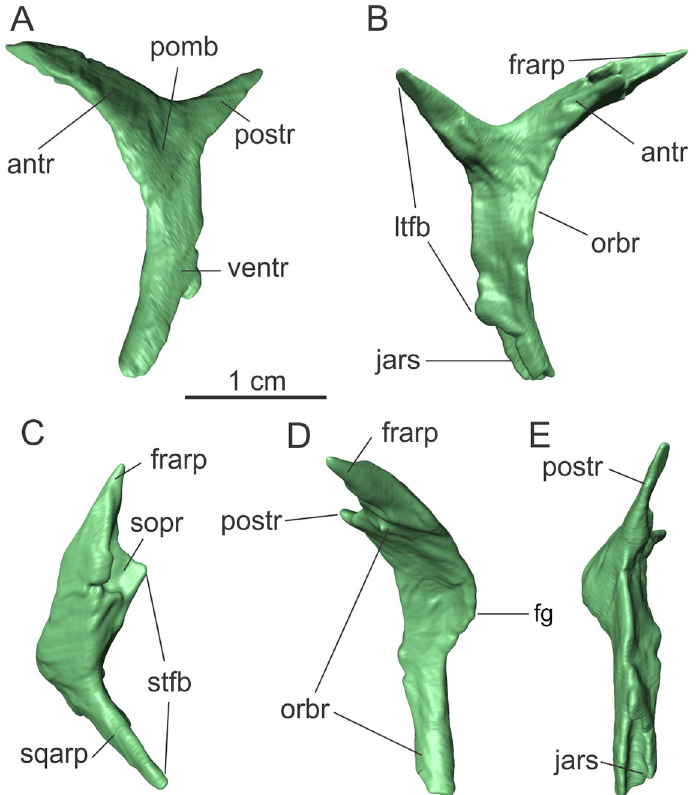
Fig 6. Left postorbital of the specimen MCP-3845-PV of Saturnalia tupiniquim in lateral (A), medial (B), dorsal (C), anterior (D) and posterior (E) views. Abbreviations : antr —anterior ramus; fg— flange; frarp— articulation process with the frontal; jars— articulation surface with the jugal; ltfb— border of the laterotemporal fenestra; orbr— orbital rim; postr— posterior ramus; sopr— socket for articulation with the parietal; sqarp— articulation process with the squamosal; stfb— border of the supratemporal fenestra; ventr— ventral ramus. On the medial surface of the lacrimal, a crest extends along the posterior margin of the shaft. It separates the groove associated with the lachrymal duct on the posterior surface of the bone from another dorsoventrally oriented, and anteroposteriorly concave, groove (‘gr’ in Fig 5D) on the medial surface of the bone, which extends dorsally for half the length of the poste- rior groove. The dorsal half of the lacrimal shaft is anteroposteriorly convex, following the con- cavity of the antorbital fossa on the lateral side of the bone. The medial surface of the anterior ramus also mostly follows the curvature on the opposite side of the bone, being dorsoventrally convex, except for its concave proximal third. This is due to the medial expansion (‘dme’ in Fig 5) of the dorsal surface of the anterior ramus in the region where it was likely overlapped by the prefrontal (‘pfars’ in Fig 5).